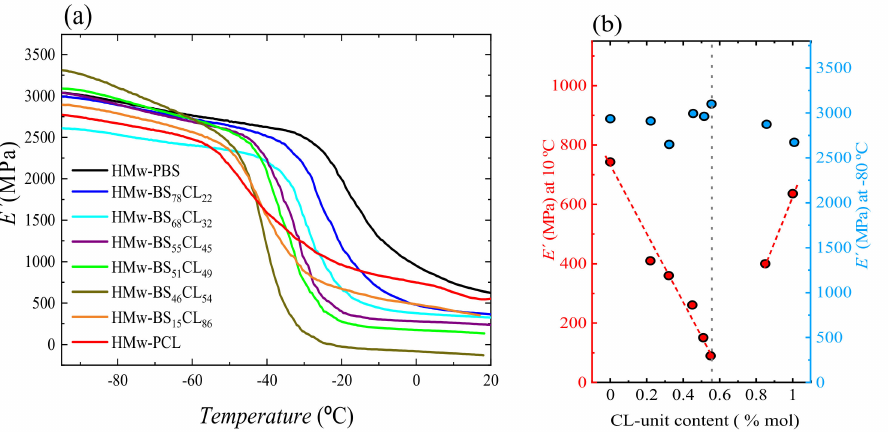
Figure 17. ( a ) Storage modulus of the HM W copolyesters as a function of temperature at 1 Hz. ( b ) Storage modulus values at − 80 ◦ C and at 10 ◦ C versus CL-unit content. The dashed vertical line shows the position of the pseudo-eutectic